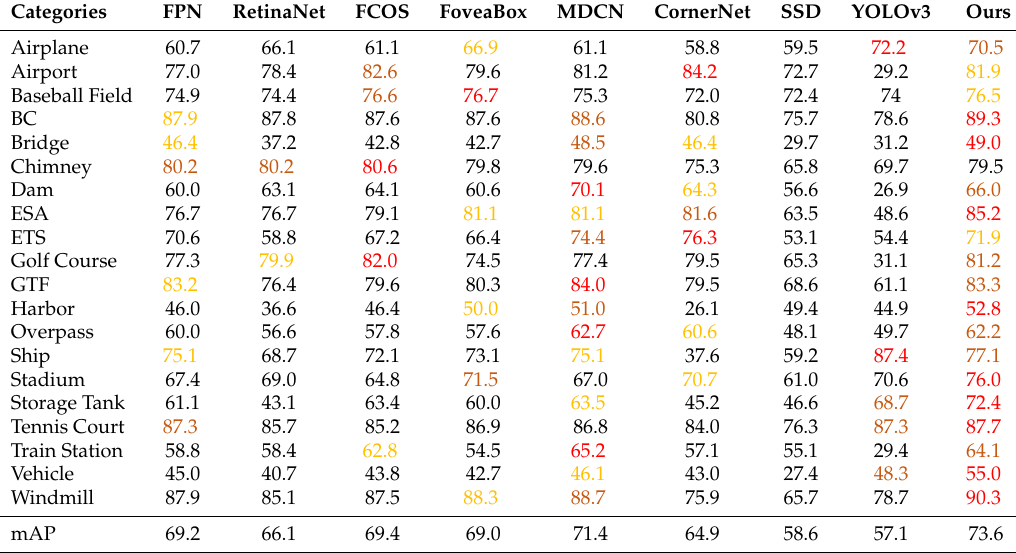
Table 1. The mean average precisions (mAPs) of different methods, where BC means the Basketball Court, ESA denotes expressway service area, ETS denotes expressway toll station and GTF is ground track field. The red, orange and yellow numbers indicate that the AP values of the corresponding methods are the highest, the second highest and the third highest in this